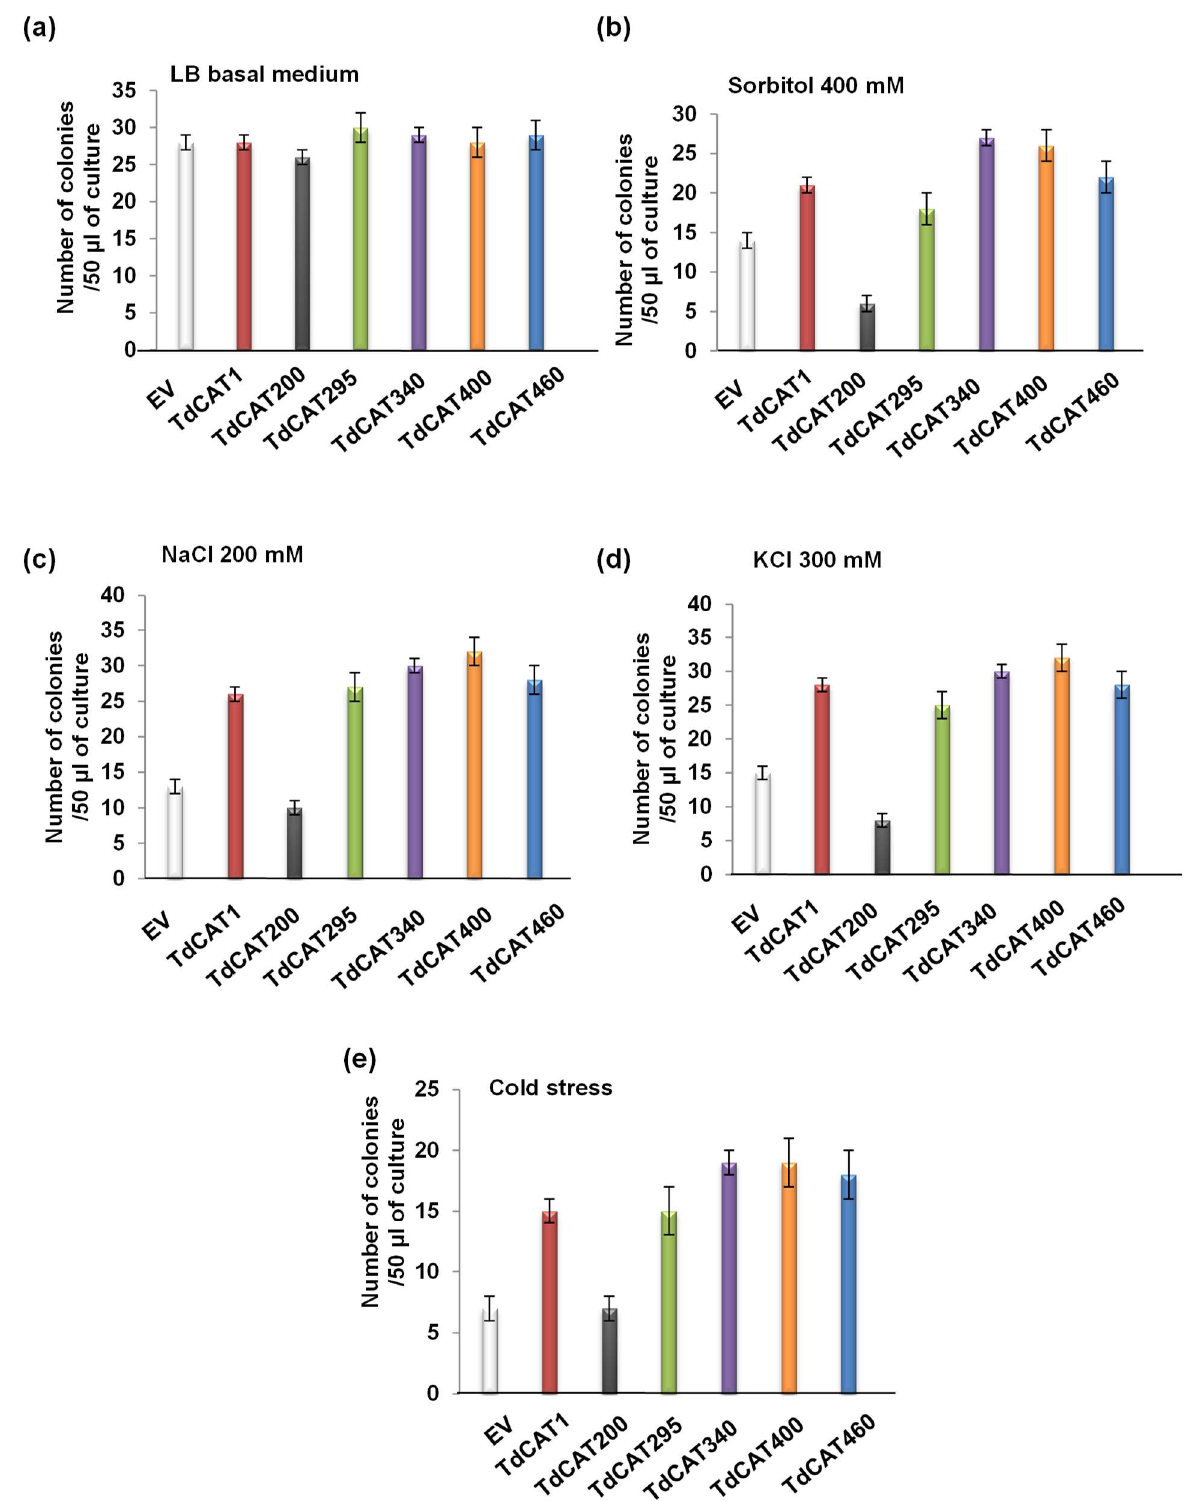
Figure 6. Percentage of cells’ viability under control ( a ), 400 mM Sorbitol ( b ), 200 mM NaCl ( c ), 200 mM KCl ( d ), or cold stress (4 °C) ( e ). Data presented are means of at least 3 independent experiments ± S.E. Mean values that were significantly different at p < 0.01 from each other are marked with asterisks indicates value significantly different from the control. Statistical significance was assessed by applying the student t-test at p < 0.01. Ev: Empty vector.